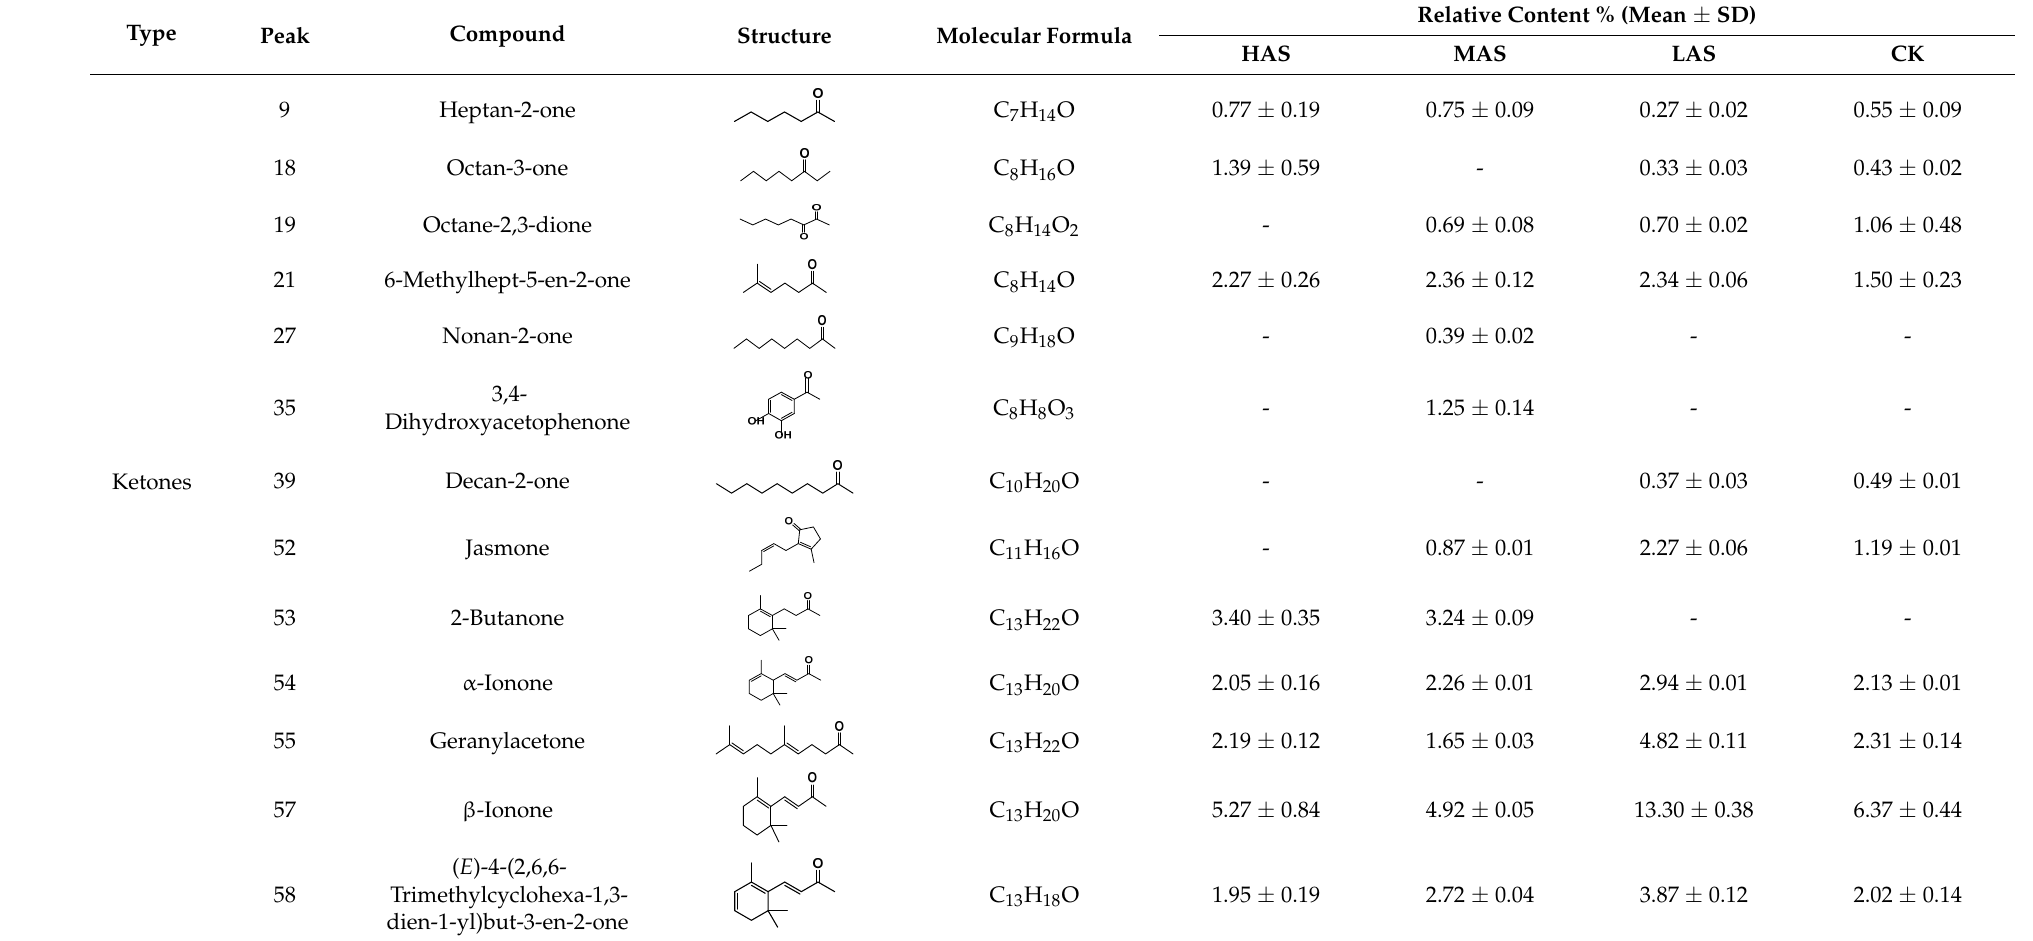
Table 2. Compounds identified in the An–tea samples.